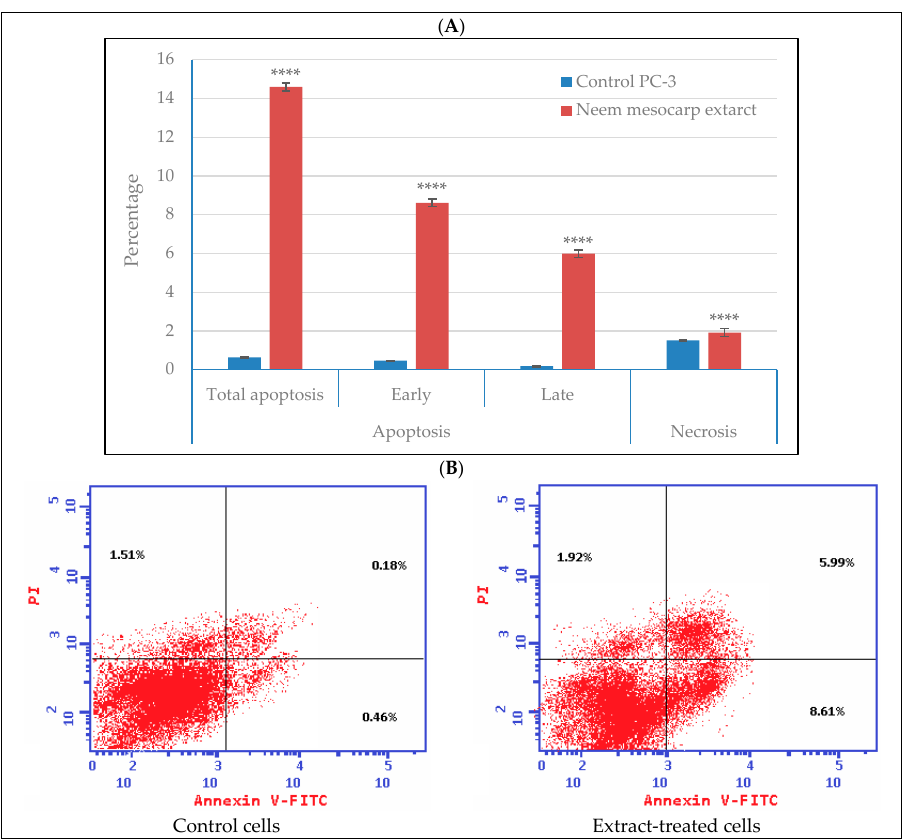
Figure 7. Apoptotic effect of methanolic fruit mesocarp extracts of neem at 111 µg/mL on PC-3 cells: ( A ) quantitative cell-cycle distribution % illustrated by the bar graph with cell growth arrest@ G2/M; ( B ) flow cytometry dot plots of extract-treated cells showing necrotic cells (upper left quadrant), late apoptotic cells (upper right quadrant), viable cells (lower left quadrant), and early apoptotic cells (lower right quadrant). Significance differences between treated and control cells were determined using unpaired t -test, **** p < 0.0001. The data presented are the means of three replicates; ± SD indicated by the vertical bars. Plants 2022 , 11 , x FOR PEER REVIEW